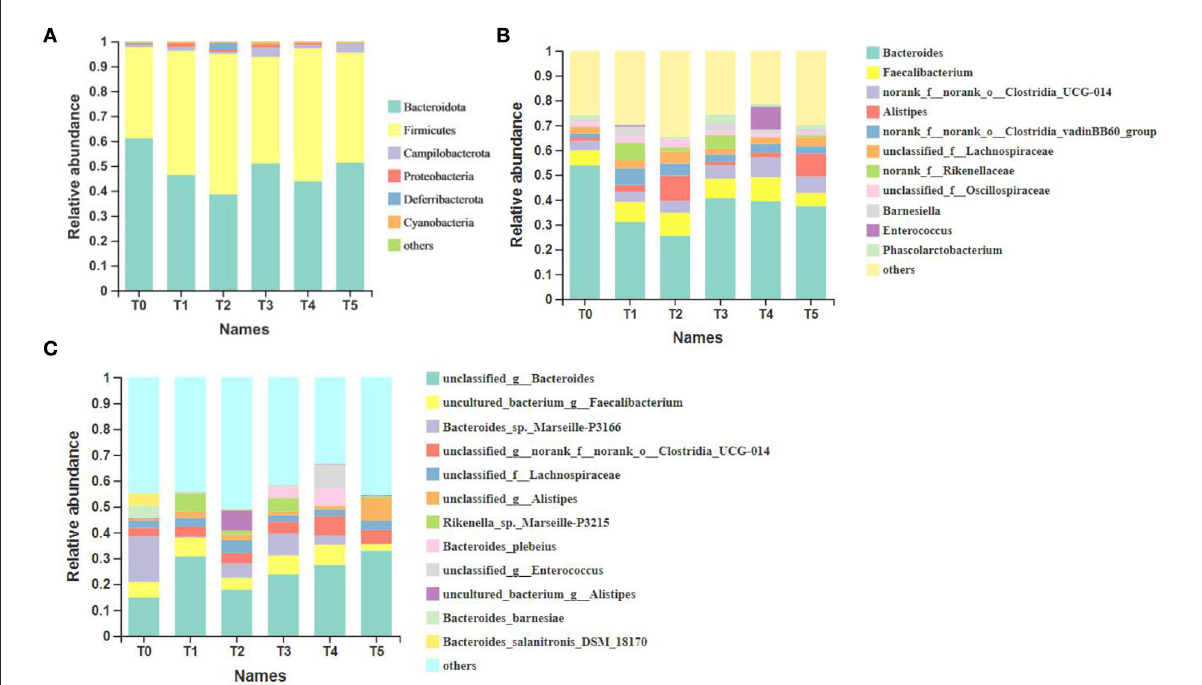
FIGURE4 All taxa at three different levels and the top more than ten most abundant taxa of all samples ( n = 6). (A) Phylum; (B) genus; (C) species. o__: order; f__: family; g__: genus. T0: fed diets based on SBM as the only protein source; T1, T2, T3, T4, T5: 1, 2, 3, 4, and 5% of CAP were